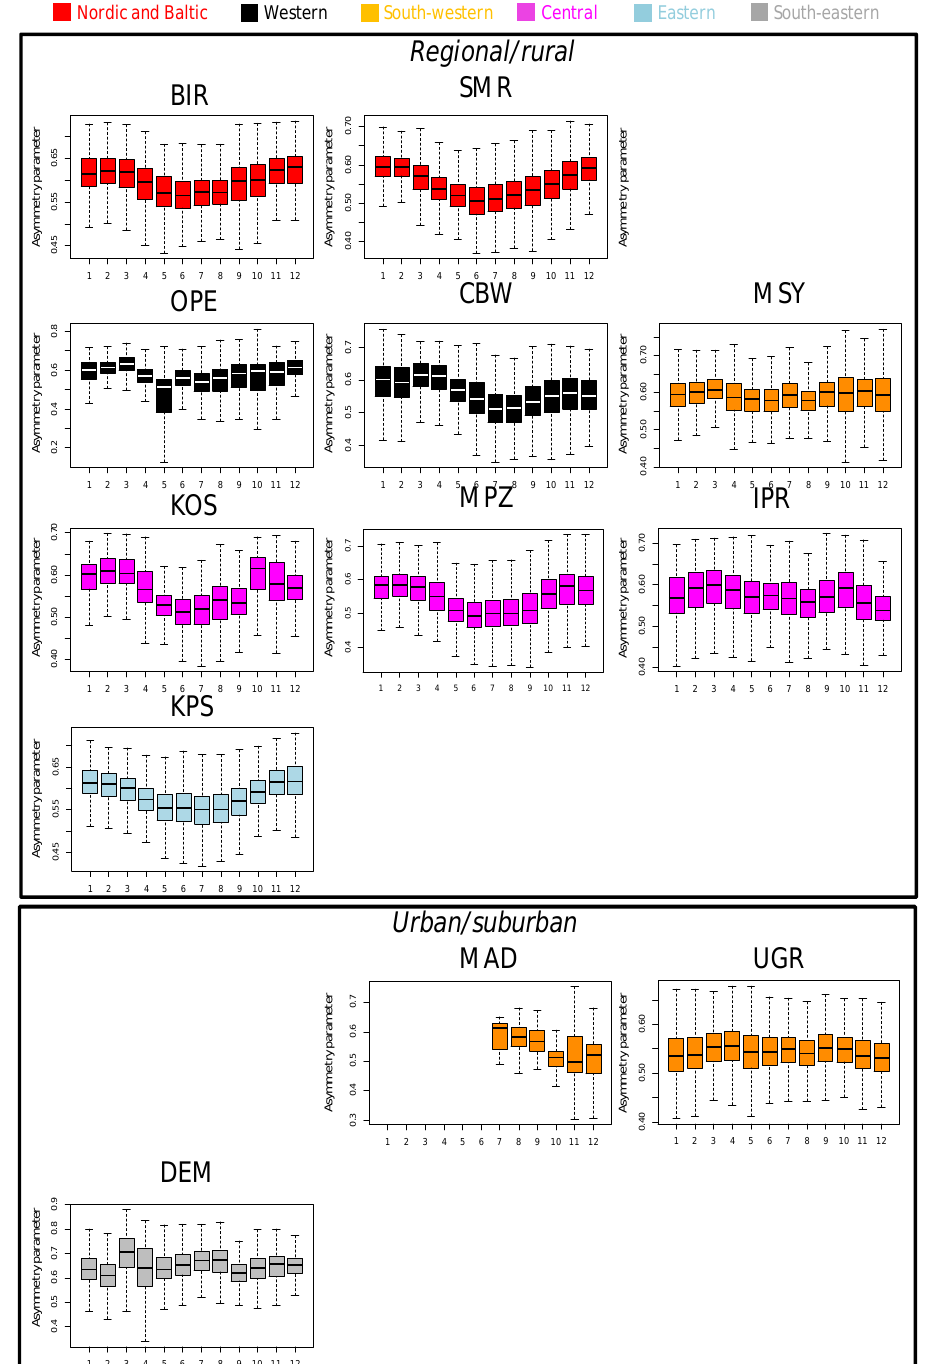
Figure 8. Seasonal cycles of g (calculated for the green wavelength). winter, whereas a higher σ sp is observed in summer at FKL (south-eastern Europe). At FKL, where no intensive optical aerosol properties are available, the higher σ sp in summer can be associated with mineral dust storm events, such as